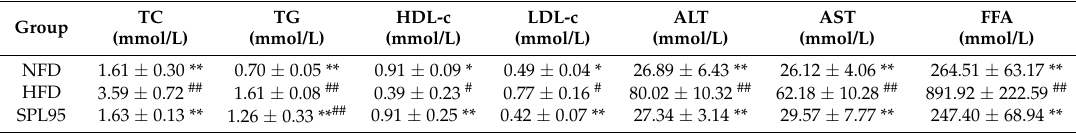
Table 2. Effect of SPL95 on TC, TG, HDL-c, LDL-c, ALT, AST, and FFA levels in the liver of rats.